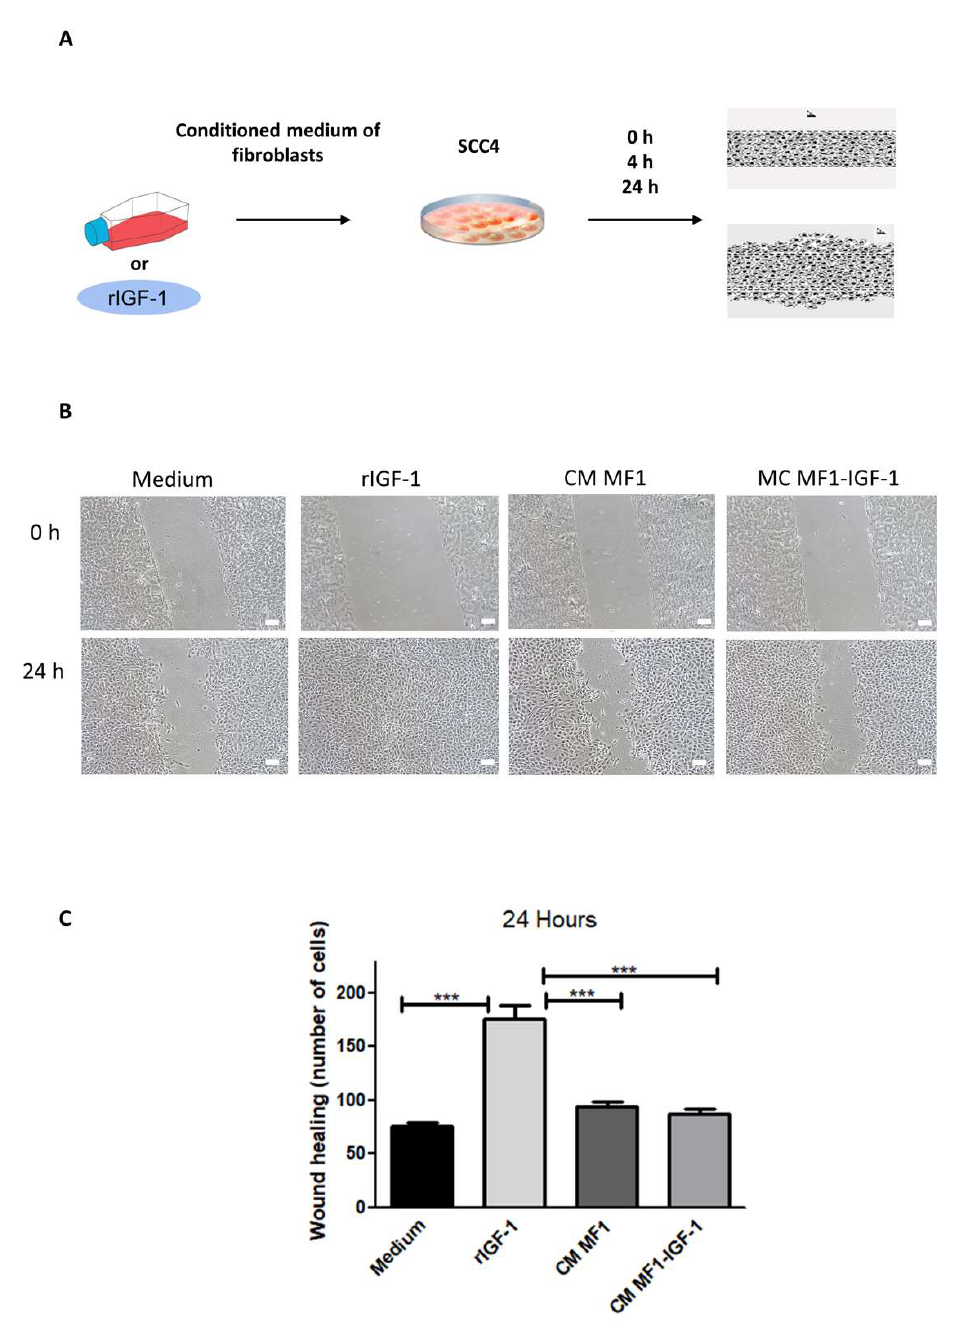
Figure 6. Evaluation of cell migration. ( A ) Experimental design of the scratch assay. ( B ) Representative images of cell migration at 0 and 24 h under di ff erent conditions. Bars: 50 µ m. ( C ) Quantification of migrating cells. Data are presented as means ± SDs, bars represent comparisons between respective groups and (***) denotes statistical significance after applying the one-way ANOVA and Dunnett’s post-test, p < 0.01. CM: conditioned